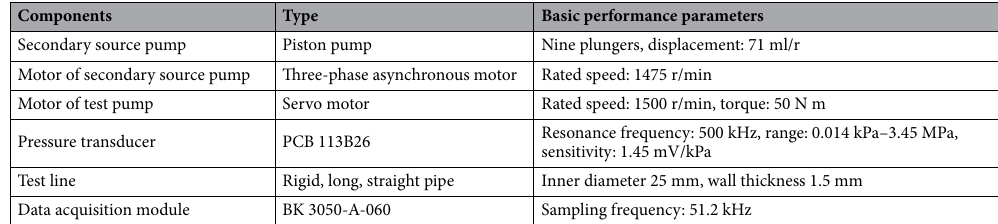
Table 6. Components selected for test platform.